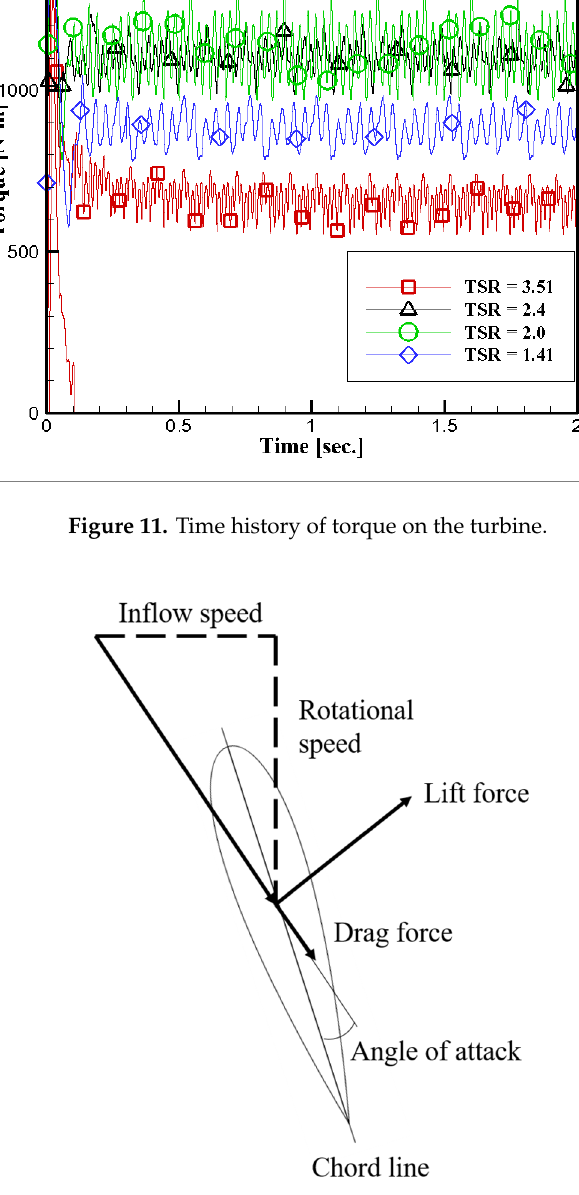
Figure 12. Schematic diagram of the angle of attack and force acting on the cross section of the turbine blade.